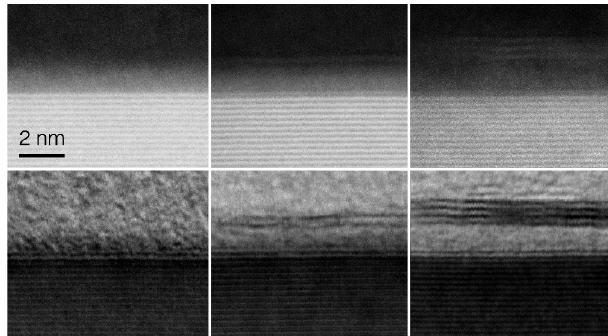
Figure 31. High-angle annular dark-field ( above ) and bright-field ( below ) STEM images at three different areas of the graphene/SiC(0001) system, showing zero ( left ), one ( center ), and three graphene layers ( right ) on top of an amorphous thin film. The acquisition took place at a 60 keV primary beam energy in order to prevent beam-induced damage [142].